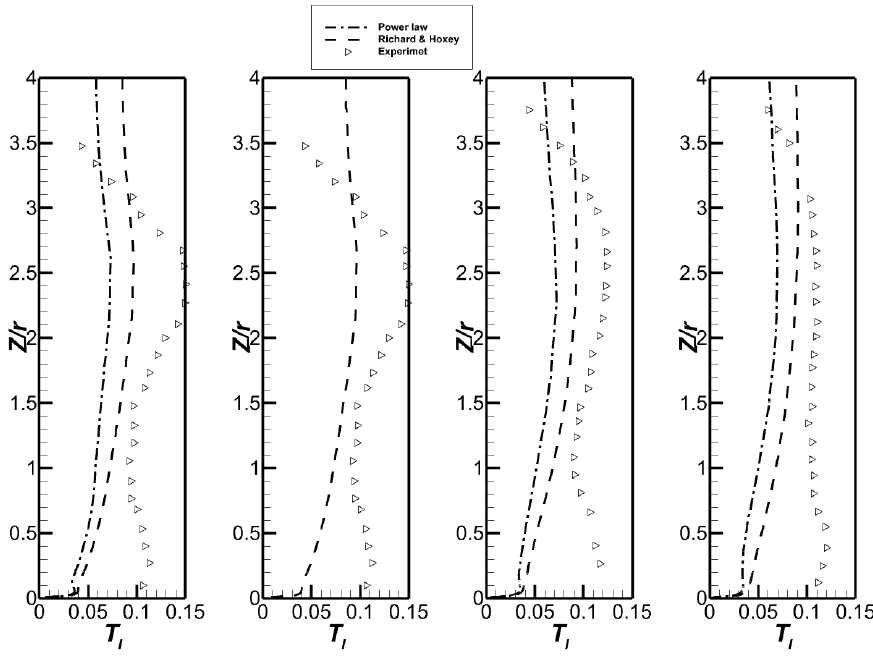
Figure 8. Turbulence Intensity at 3 D 5 D 10 D 15 D from left to right.